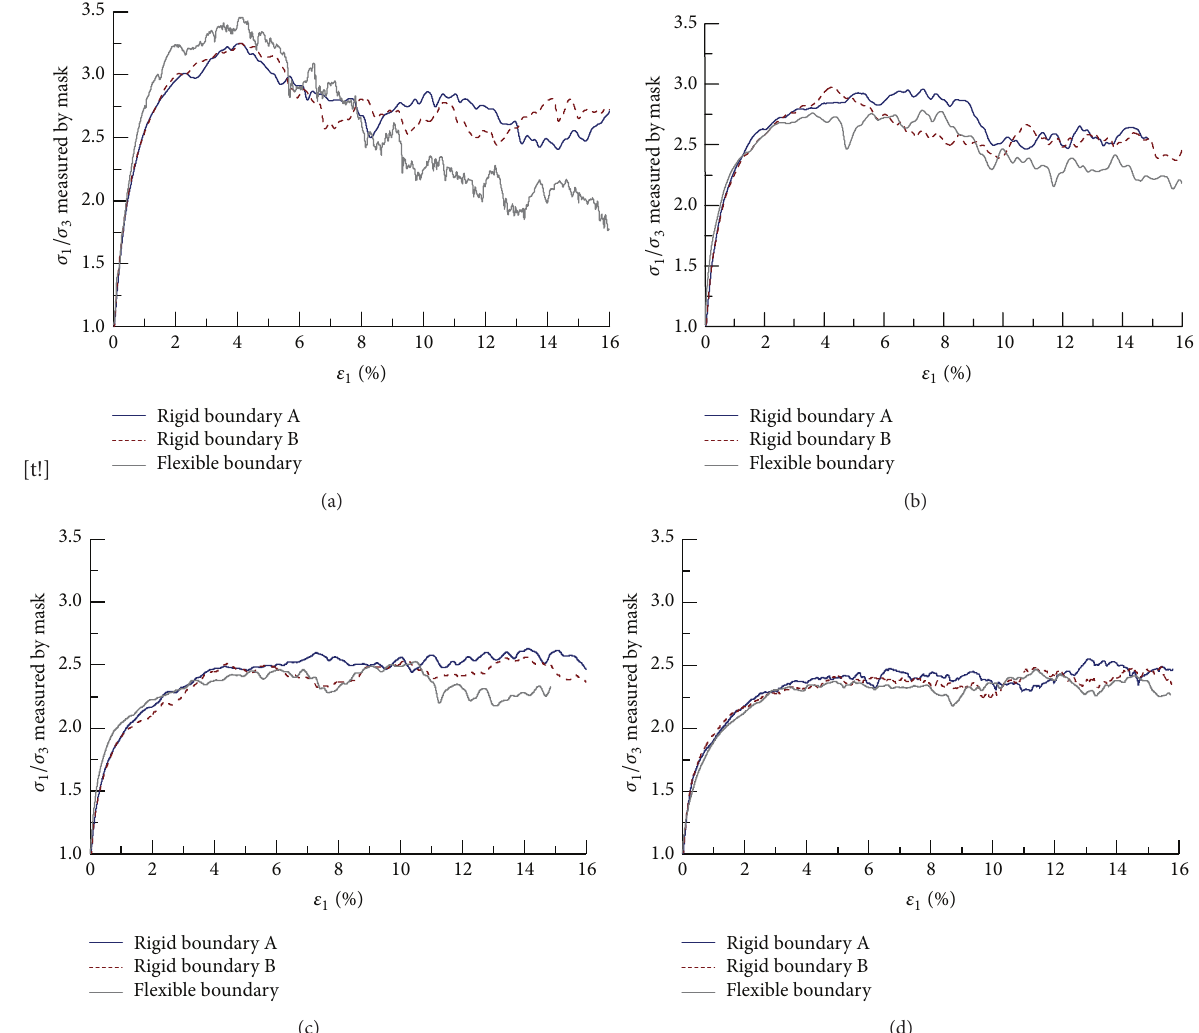
Figure 10: The development of “real” stress ratio 𝜎 1 /𝜎 3 with axial strain 𝜀 1 for three different boundary conditions: (a) 𝛿 = 0 ∘ , (b) 𝛿 = 30 ∘ , (c) 𝛿 = 60 ∘ , and (d) 𝛿 = 90 ∘ . The 𝜎 1 and 𝜎 3 are measured inside the specimen by defining a